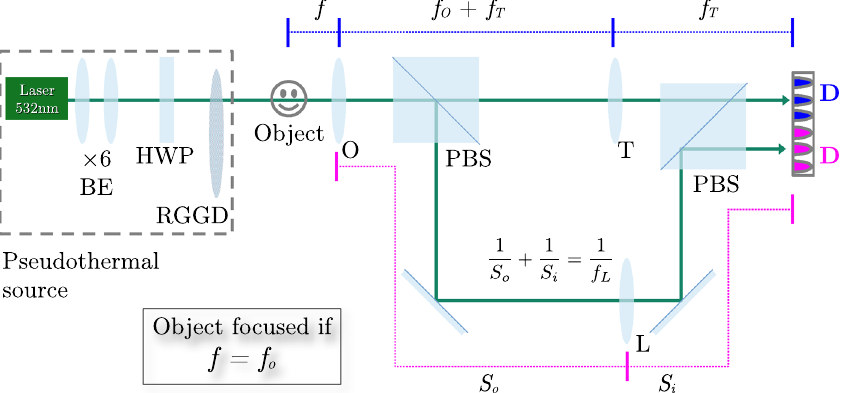
Figure 6. Experimental setup for CLM. Light produced by a chaotic source, made of a laser, a beam expander (BE), a half-wave plate (HWP) and a rotating ground-glass disk (RGGD), illuminates the object, is collected by the objective lens (O), and reaches the first polarizing beam splitter (PBS). The transmitted beam passes trough the tube lens (T) and the second PBS, and finally impinges on the detector D a , which is the (blue) half of the sensor of the CMOS camera. The focused image is characterized by magnification M = f T / f O = 4.2 . The reflected beam passes through the additional lens L and then is reflected by a second PBS toward detector D b , which is the disjoint (magenta) half of the sensor on the same sCMOS camera. The magnification of the objective lens O on D b is M L = 0.31 . All the experimental results shown in the article are obtained in this